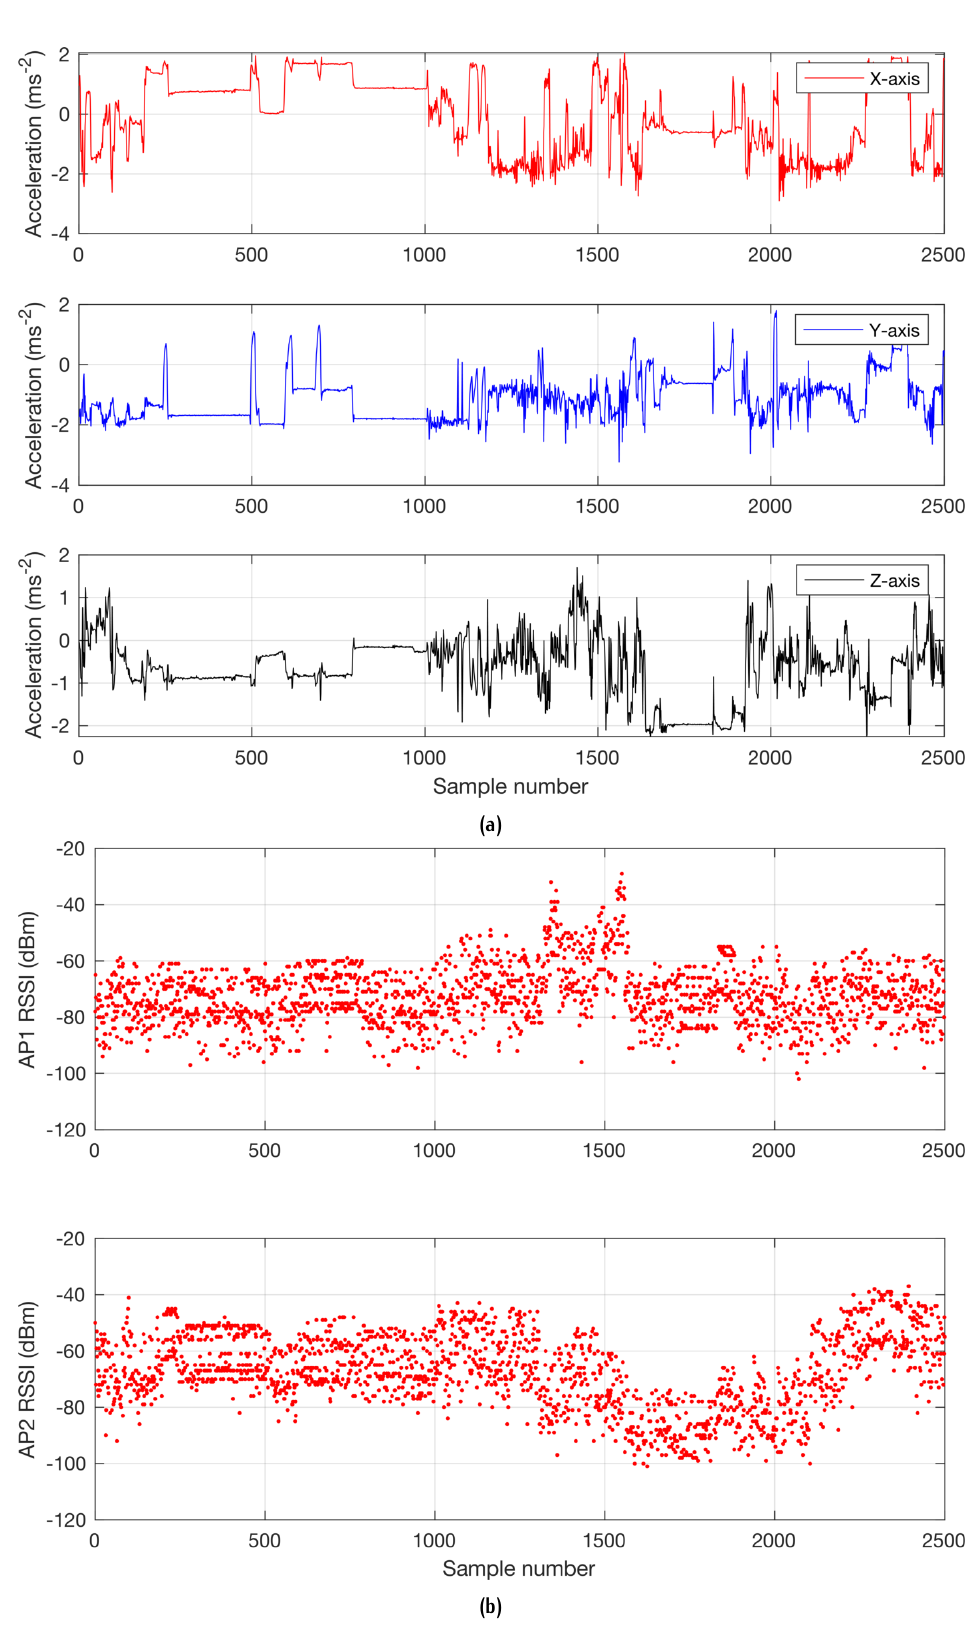
Figure 2. Example of tri-axial Accelerometer (2a) and RSS (2b) time series data from an indoor localisation ’living’ experiment. Courtesy of Byrne et al.